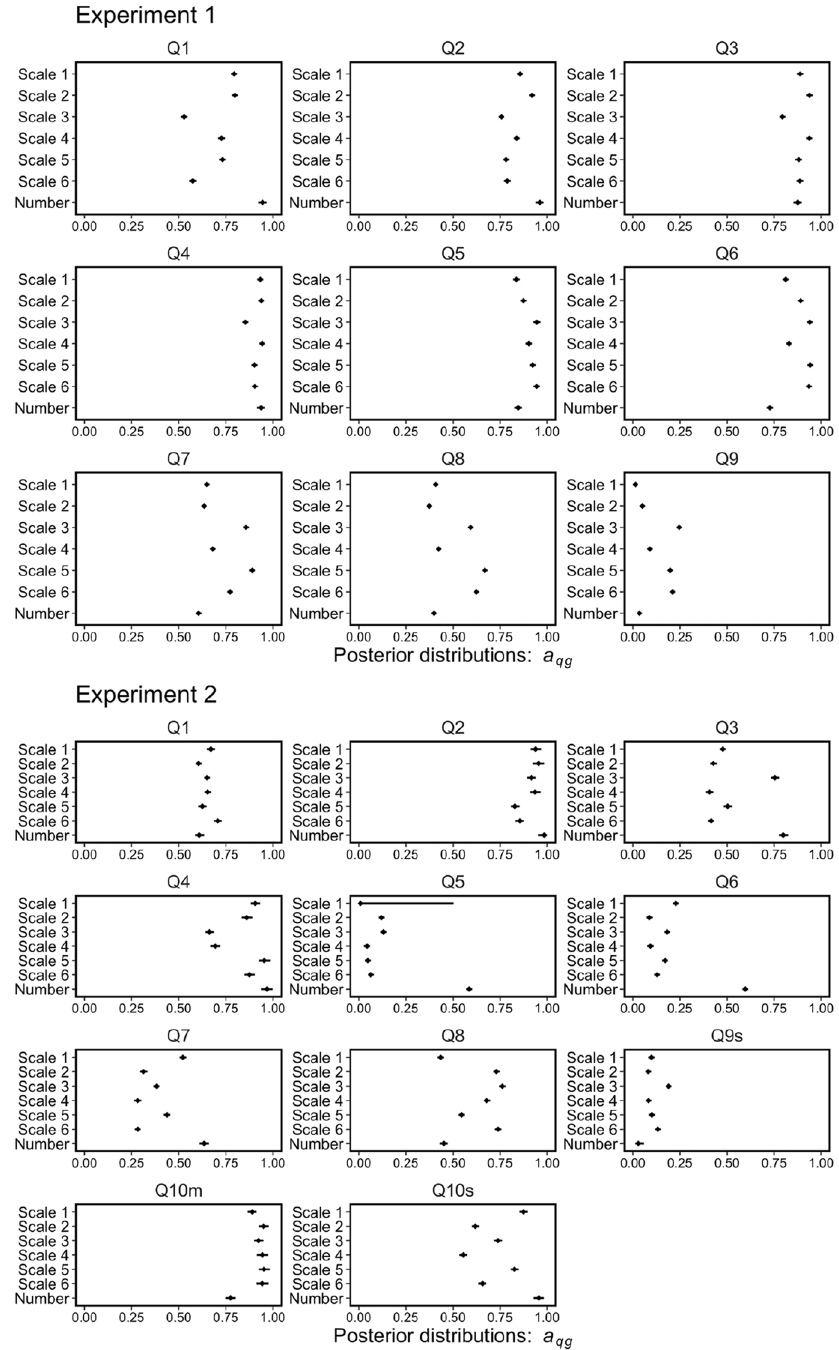
Figure 9. Posterior distributions of the parameters, a qg , in Eq. (3). The point (or error bar) indicates median (or 95% Bayesian credible